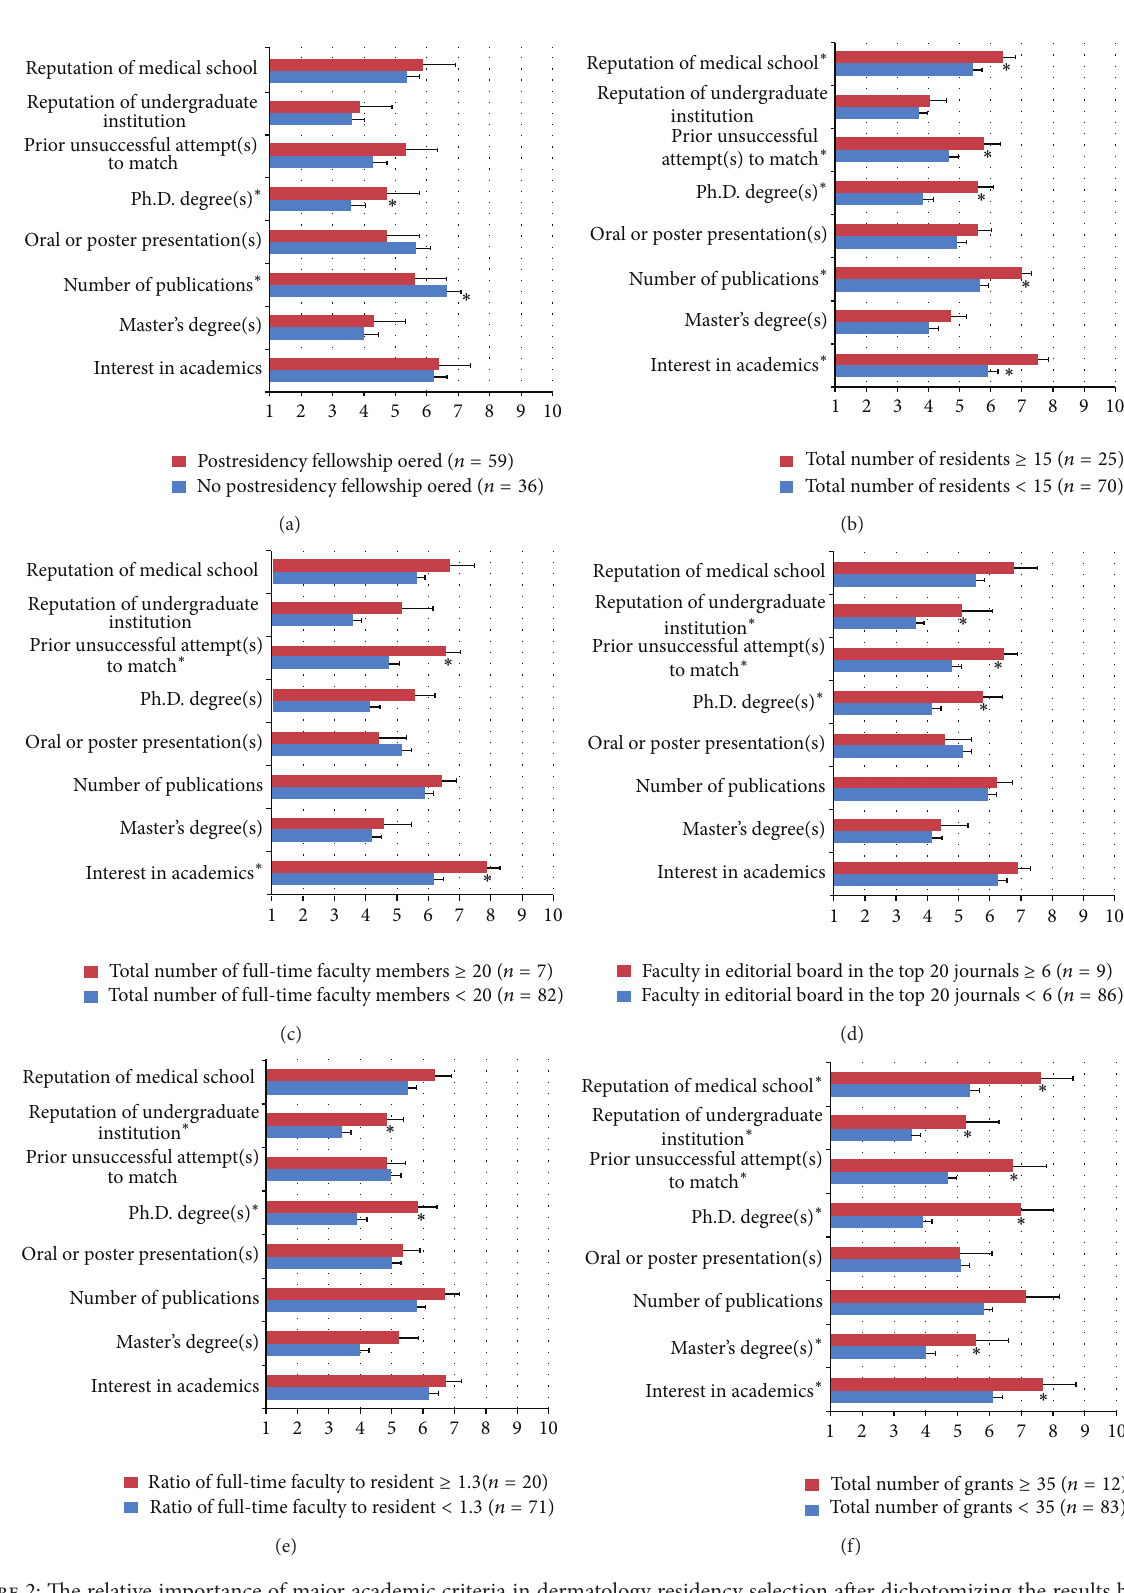
Figure 2: The relative importance of major academic criteria in dermatology residency selection after dichotomizing the results based on the programs that offered postresidency fellowships or not (a), the number of residents (b), the number of full-time faculty members (c), the number of faculty members on the editorial board in the top 20 dermatology journals (d), the ratio of (full-time) faculty/resident (e), and total number of grants (f). ∗ The comparisons with asterisks are statistically significantly different from each